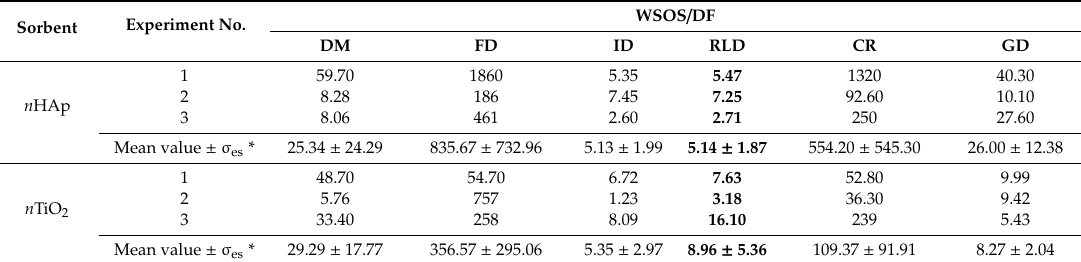
Table 4. The evaluation of kinetic dependences by six di ff erent models (Table 1) based on the values of WSOS / DF (weighted sum of squares divided by degrees of freedom) characterizing the agreement between the experimental (22 ± 1 ◦ C) and calculated